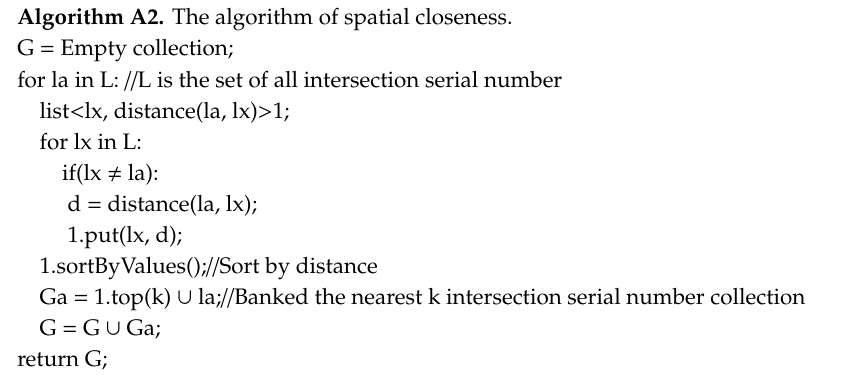
Algorithm A2. The algorithm of spatial